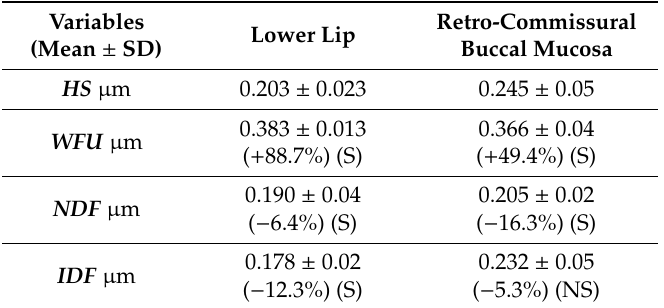
Table 3. Capillary length (% di ff erences with